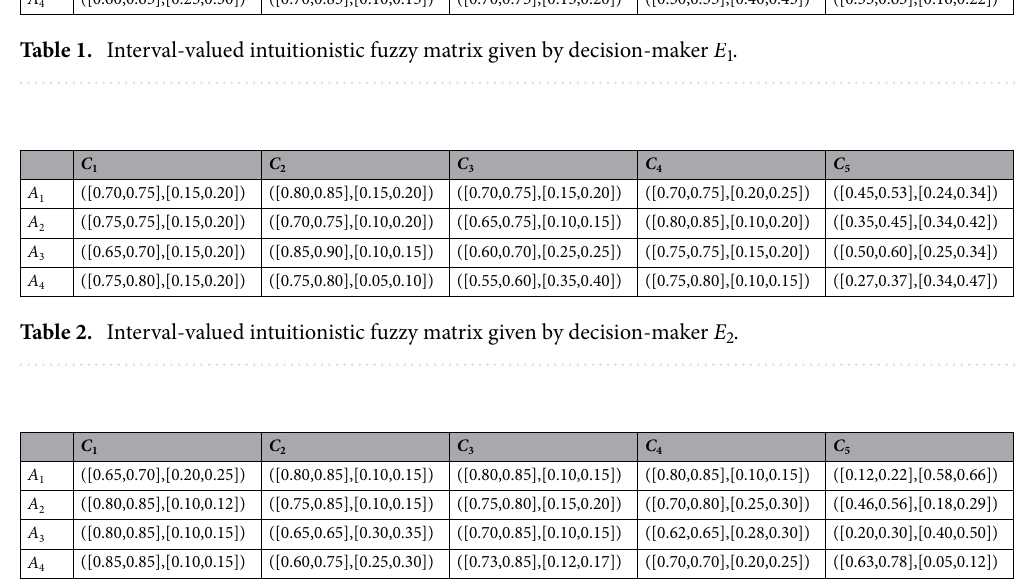
Table 3. Interval-valued intuitionistic fuzzy matrix given by decision-maker E 3 .